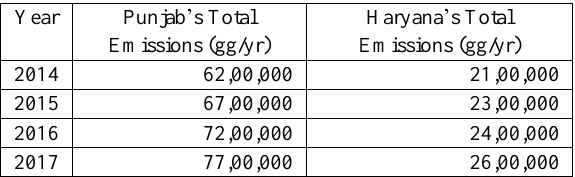
Table 2: Total State Emissions from 2014 to 2017